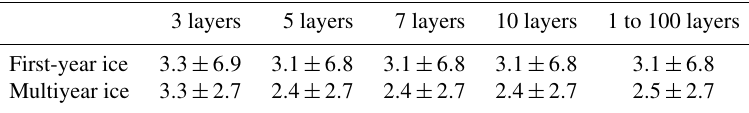
Table 3. Absolute mean difference and standard deviation (K) between simplified brightness temperatures simulated based on profiles interpolated on different number of layers and reference brightness temperatures simulated based on profiles covering 1 to 100 layers, depending on the thickness of the ice. These values only represent cold conditions (October to